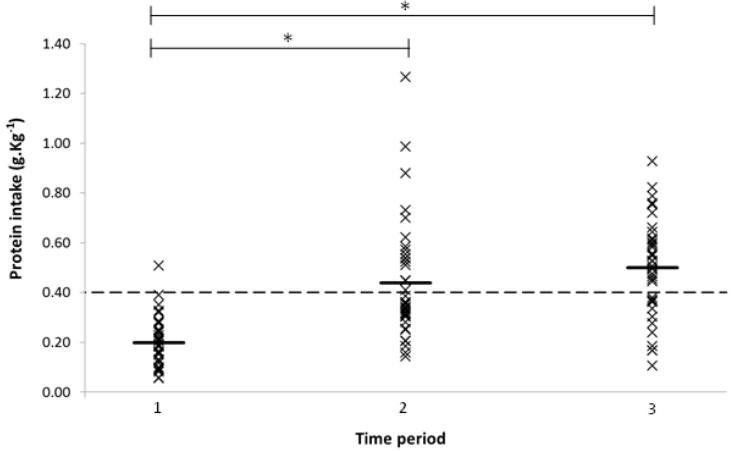
Figure 2. Mean protein intake for each participant by time period (05:00–11:00, 11:00–16:00, 16:00– 23:59), bars represent mean for each period. Dashed line represents 0.4 g ∙ kg − 1 threshold. * indicates significant differences between periods ( p < 0.05).